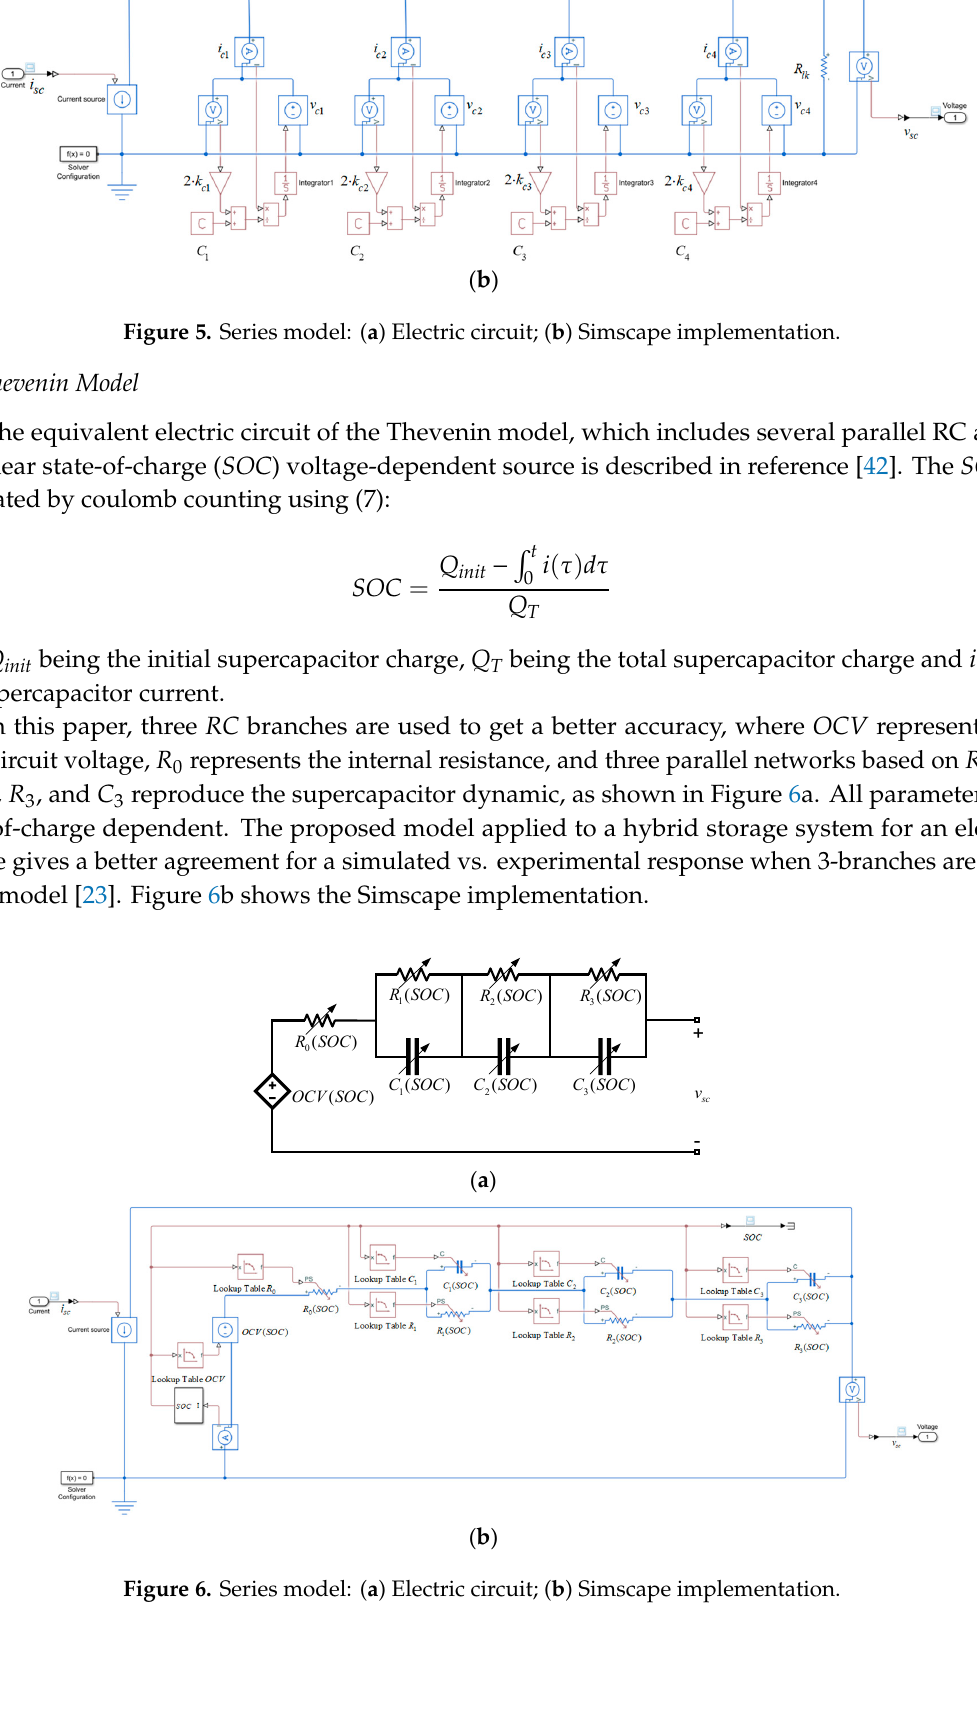
Figure 5. Series model: ( a ) Electric circuit; ( b ) Simscape implementation.